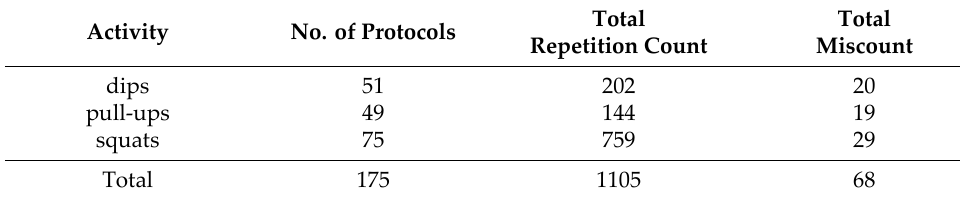
Table 11. Repetition count results.